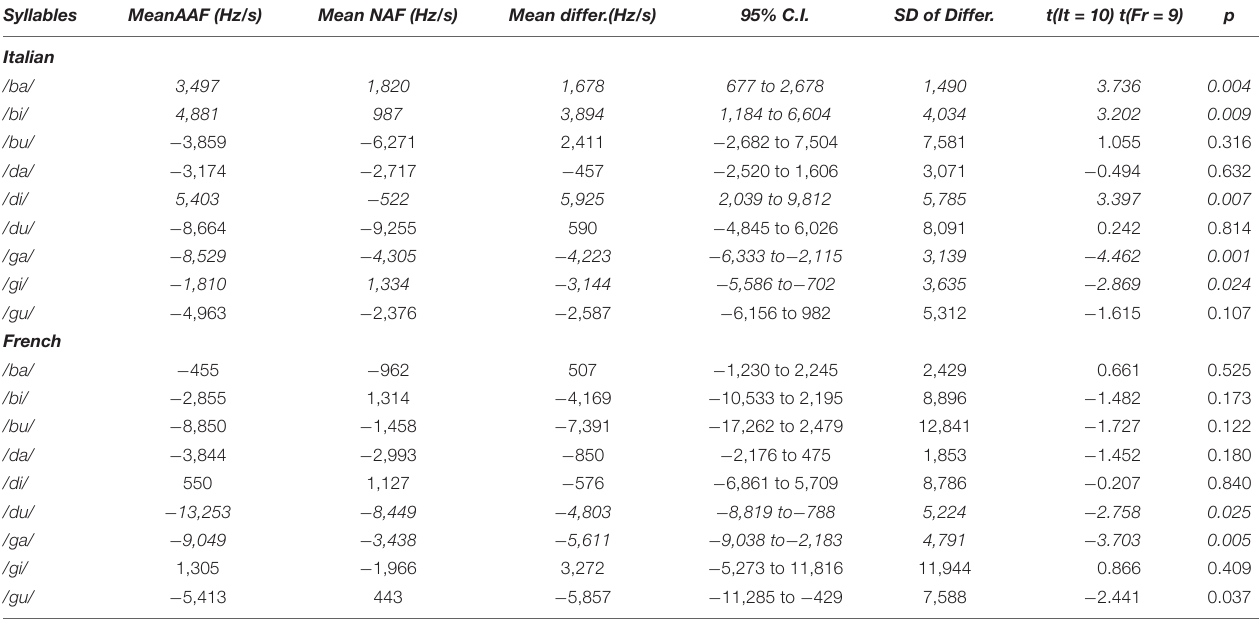
TABLE 8 | For each syllable and each language under NAF and AAF condition: Mean values (Hz/s) of (cid:49) F2 beg / (cid:49) t, mean of the difference (Hz/s), 95% of the Confidence Interval (Hz/s), Standard Deviation of the Differences (Hz/s), t value (Degrees of Freedom), and p value (matched pairs t -tests). Syllables MeanAAF (Hz/s) Mean NAF (Hz/s) Mean differ.(Hz/s) 95% C.I. SD of